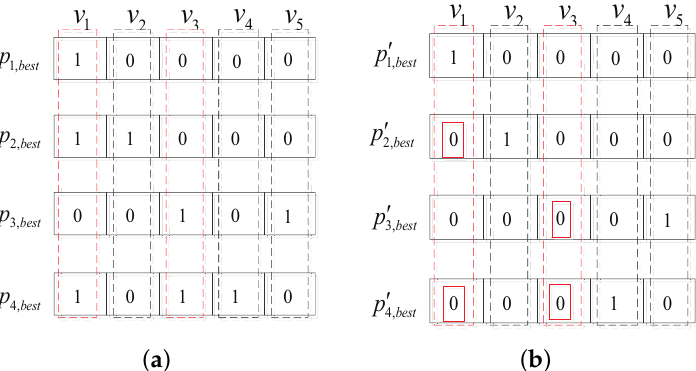
Figure 9. The processing method of common vertices: (a) Hypergraph obtained at the current iteration; ( b ) hypergraph after processing common